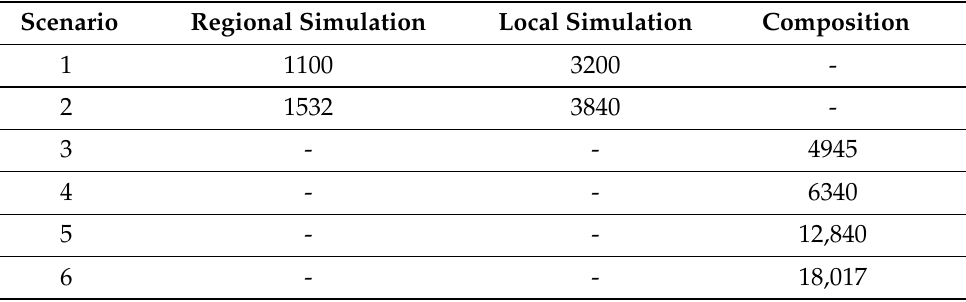
Table 2. Execution times (in seconds) of the different scenarios in